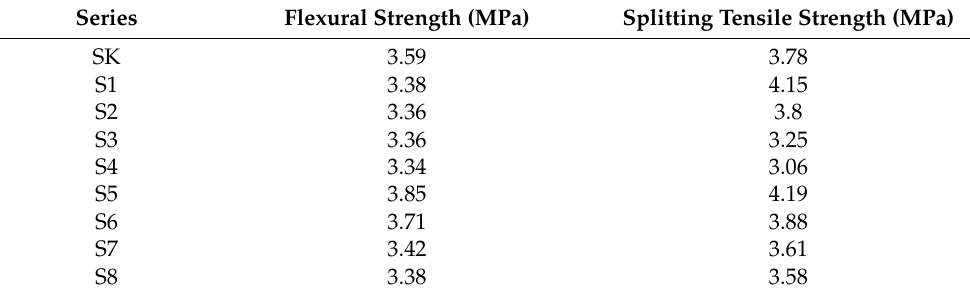
Table 5. Flexural tensile strength and splitting tensile strength of concrete. Series Flexural Strength (MPa) Splitting Tensile Strength